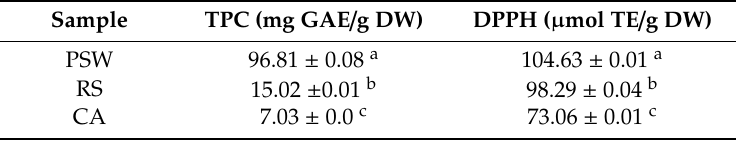
Table 2. Total phenolic content (TPC) and DPPH of PSW, RS and CA extracts.